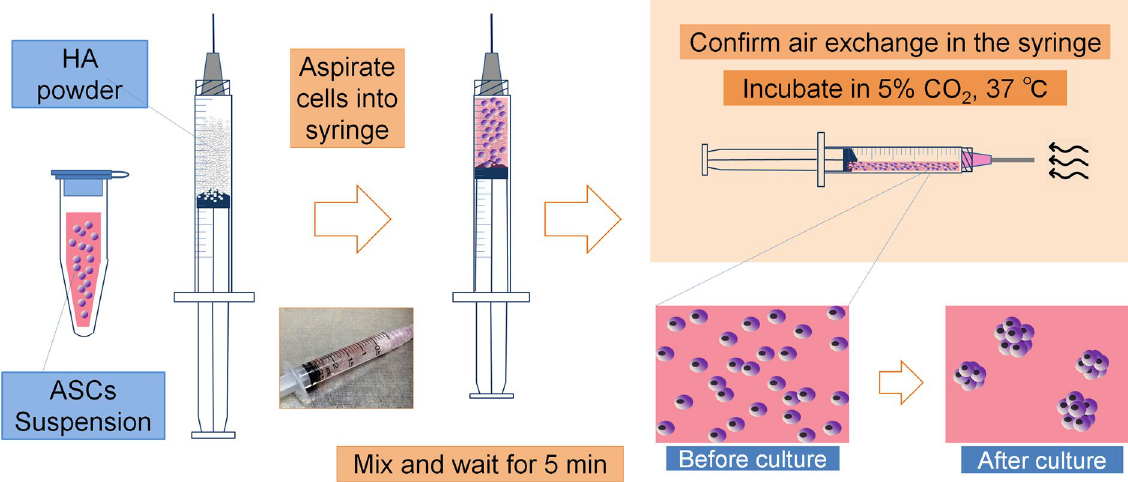
Figure 7. ASC spheroid formation in HA gel. Schematic diagram of the preparation of ready-to-inject HA spheroids. HA powder was weighed and transferred to a syringe. Monolayer-cultured ASCs were trypsinized, counted, suspended in growth medium, aspirated into the syringe, and mixed with the powder, which was then allowed to dissolve for 10 min. The plunger was drawn back to assure air exchange through the needle. The needle cap then closed, and the syringe was incubated at 5% CO 2 and 37 °C. The gel slowly sank to the lower half of the